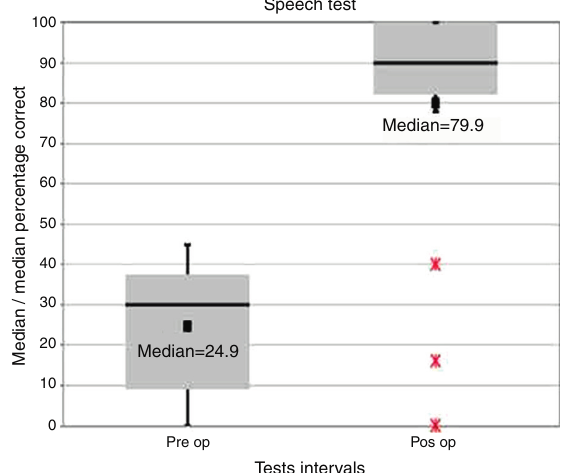
Results of the speech test: comparison between pre- operative versus postoperative tests (as a percentage). Mean values are shown as black parcels, medians as horizontal lines. Red asterisk represents outliers.